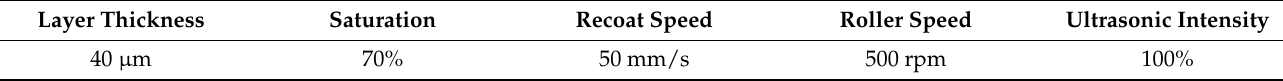
Table 2. Manufacturing parameters of the binder jetting